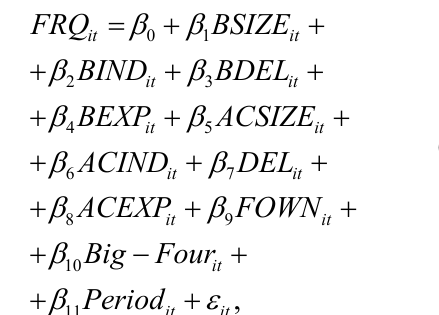
Table 1. Descriptive statistics of CG attributes